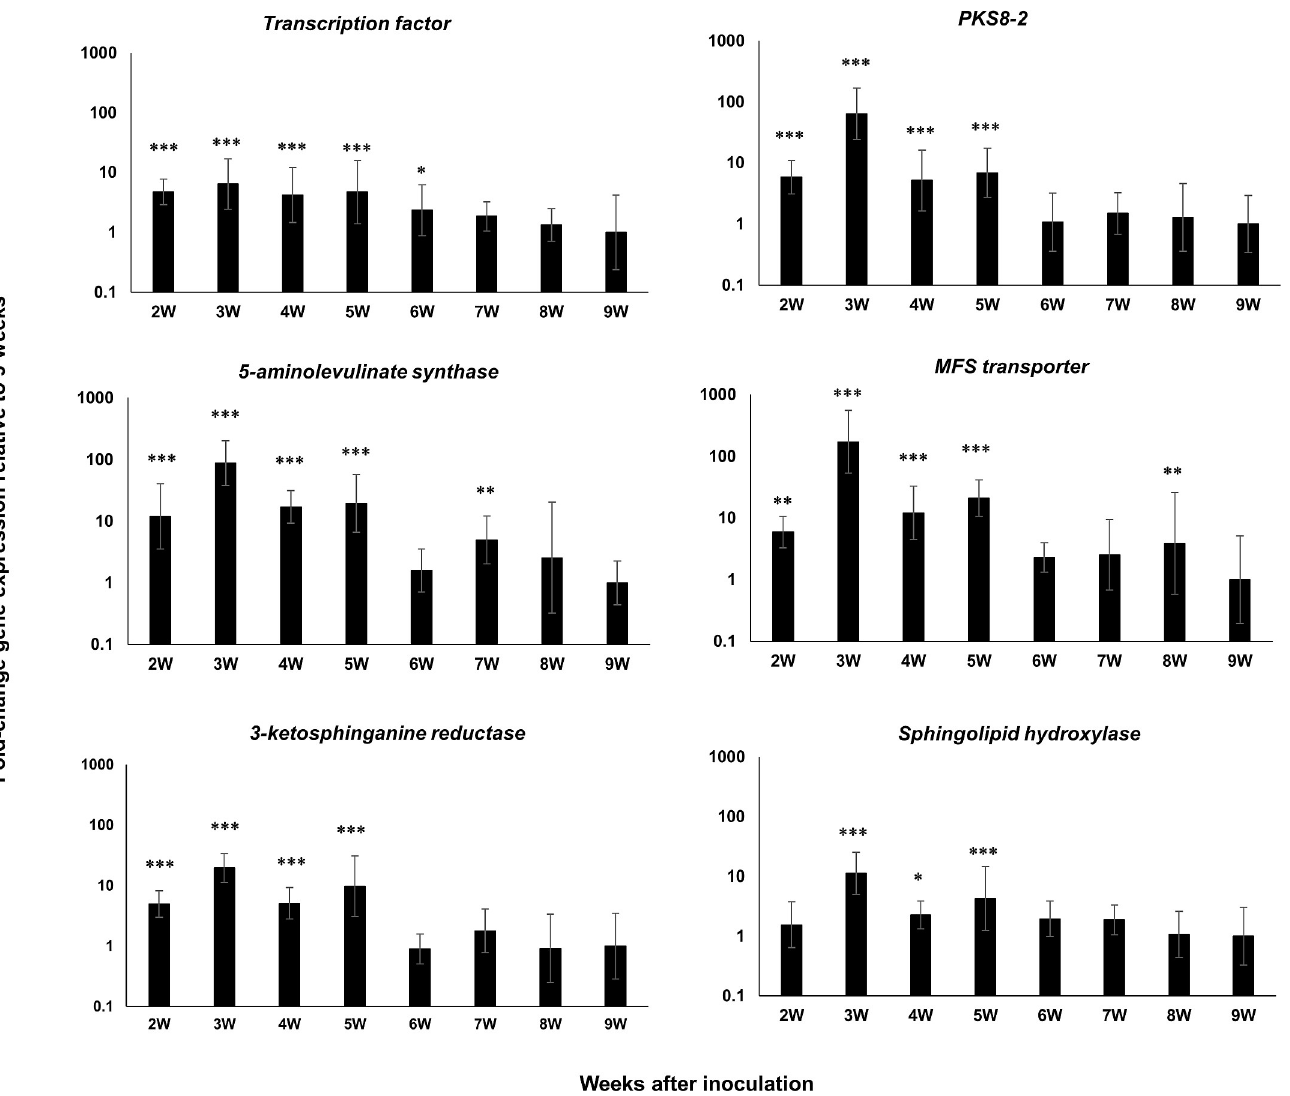
Fig 4. Time course of fold-change gene expression of PKS8-2 cluster genes in wild type P . fijiensis isolate 10CR1-24 in infected banana relative to expression at 9 weeks. PKS8-2 cluster genes assessed include the transcription factor, PKS8-2 , the 5-aminolevulinate synthase, the MFS transporter, the ketosphinganine reductase, and the sphingolipid hydroxylase genes. Tissue from inoculated banana plants was harvested and assayed weekly starting at 2 weeks post-inoculation through 9 weeks. Samples were normalized with reference genes indicated in Table 1. Fold-change gene expression is shown relative to the expression at 9W post- inoculation that is set to 1. Statistical significance was assessed using one-way ANOVA combined with Dunnett’s multiple comparison analysis using the normalized transcript of the 9W sample as the control group. Differences in gene transcript levels considered statistically significant are denoted by asterisks ( � P < 0.05, �� P < 0.01, and ��� P < 0.001). Error bars indicate standard error from three biological replicates. Each biological replicate was tested with three technical replicates.